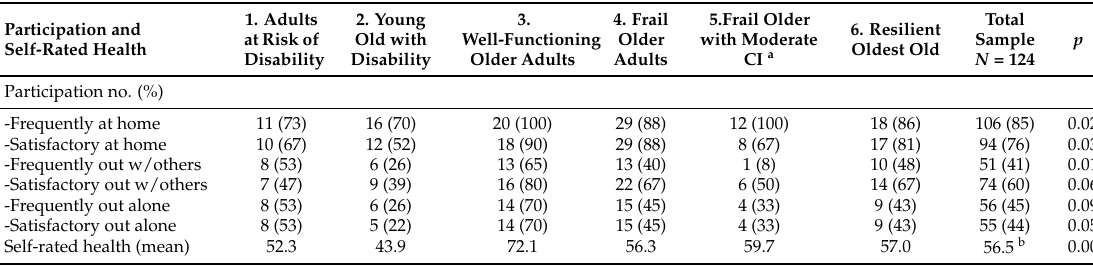
Table 3. Relationship between clusters and participation and self-rated